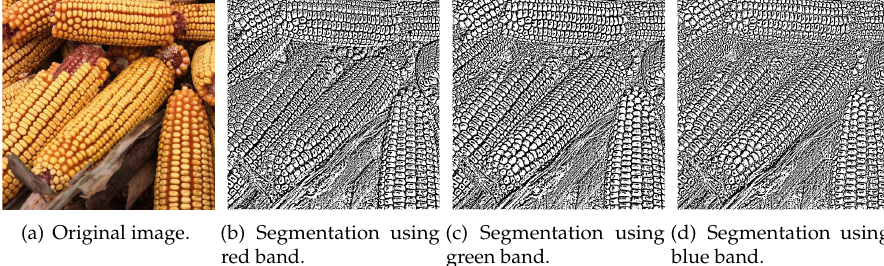
Figure 2. Example on conventional image segmentation